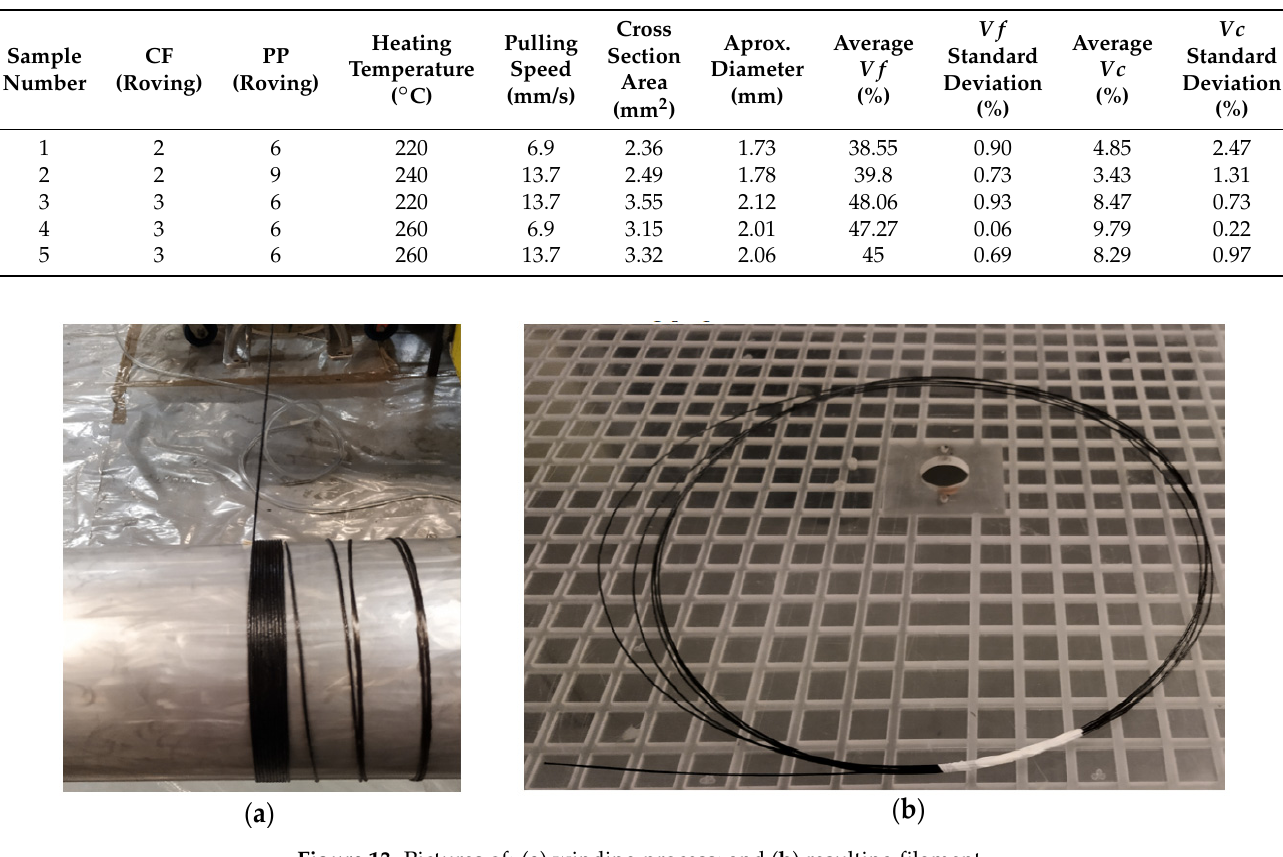
Figure 13. Pictures of: ( a ) winding process; and ( b ) resulting